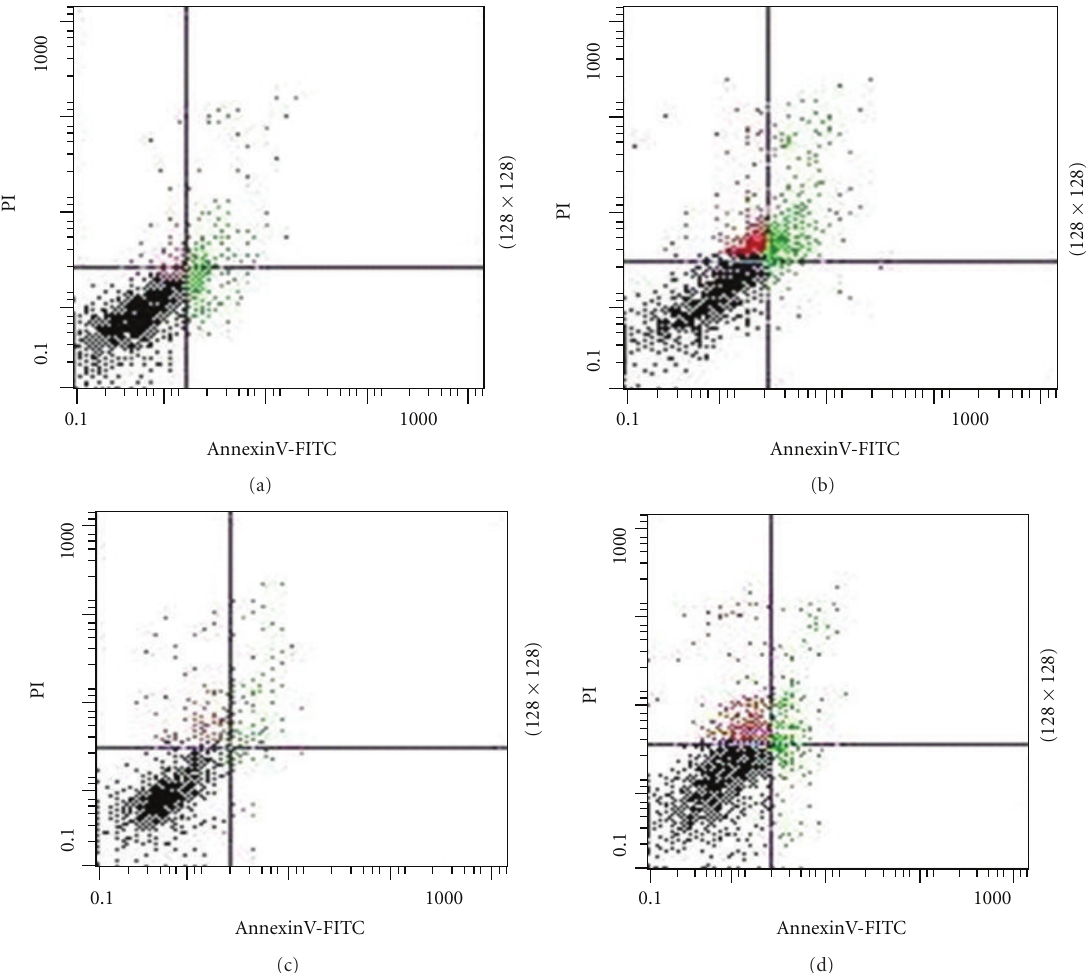
Figure 3: A549 cell apoptosis under normoxia. (a) control group; (b) Radiotherapy alone group; (c) Endostar alone group; (d) Endostar + radiotherapy.